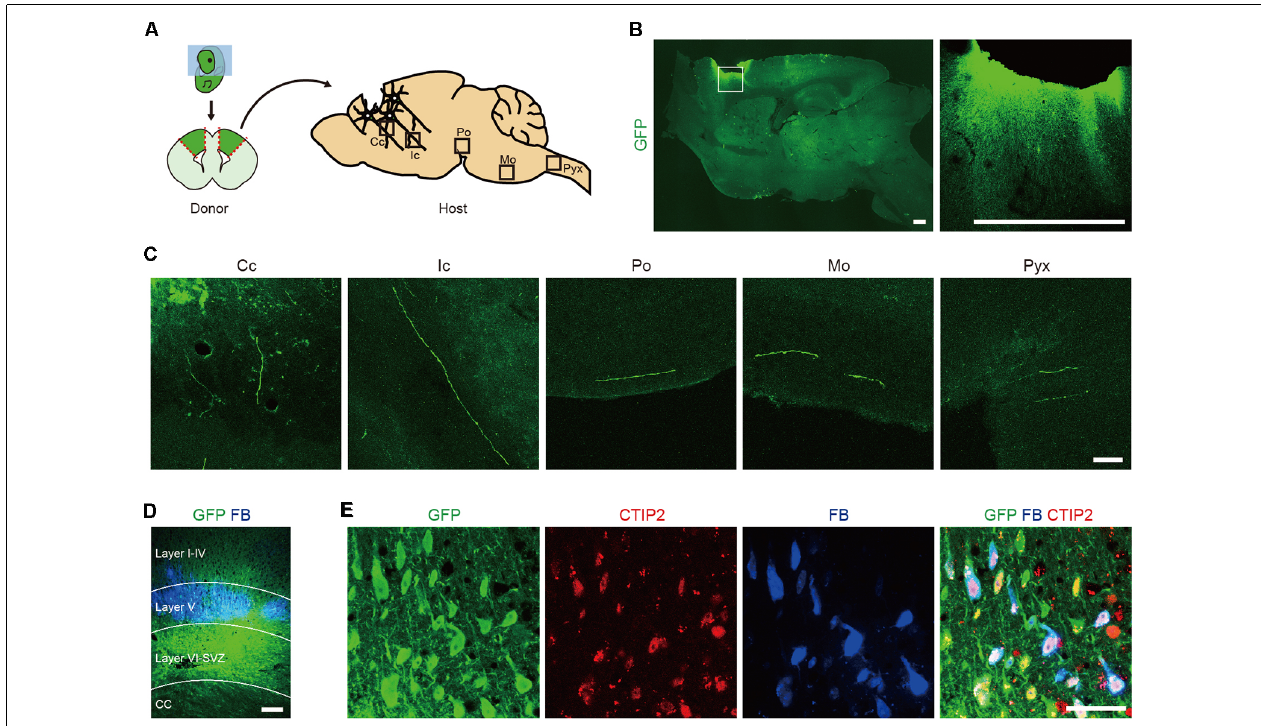
FIGURE 1 | The frontal cortex of E14.5 mouse contains Corticospinal motor neurons (CSMNs) and their progenitors. (A) Schematic of the transplantation of fetal cortical tissue from E14.5 GFP Tg mice into the lesion cavity of adult mice. (B) After 2 months, the transplanted cells survive and extend axons into the host brain, as shown by GFP + fiber innervations. Scale bars represent 500 µ m. (C) GFP + fibers were found in the corpus callosum (Cc), internal capsule (Ic), pons (Po), medulla oblongata (Mo) and pyramidal decussation (Pyx). Scale bar represents 50 µ m. (D) FB was injected into the pyramidal decussation at 7 days before sacrifice. GFP + /FB + cells were found in the cortical layer V. Scale bar represents 200 µ m. (E) Immunofluorescence images of a graft stained with anti-GFP (green) and anti-CTIP2 (red) antibodies. GFP + /FB + cells expressed CTIP2. Scale bar represents 50 µ